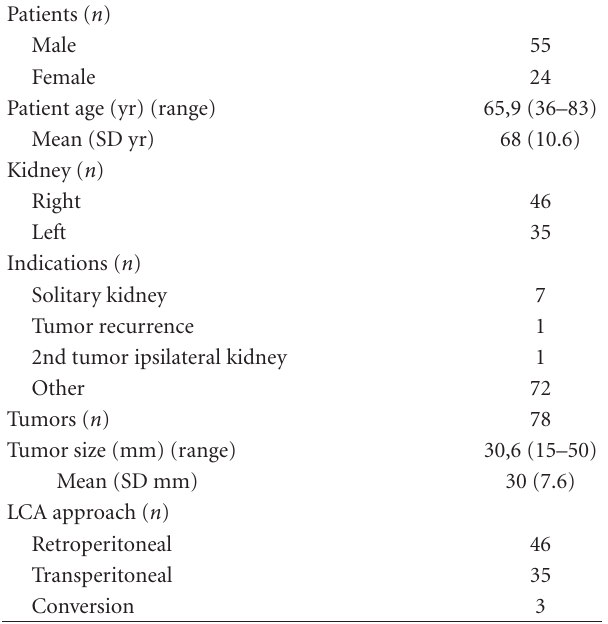
Table 1: Patient and tumor characteristics. Table 2: Pathological characteristics of 77 intraoperatively biopsied renal masses.